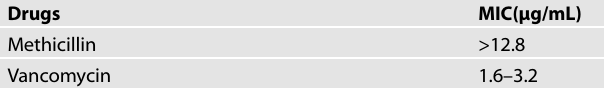
Fig. 6 Drug testing methods for mPEOs in the USA300 infection model. A Overview of the three methods protocol steps (created with BioRender.com). The viability of infected mPEOs after treatment with DMSO, 12.8 μ g/mL methicillin, 1.6 μ g/mL and 3.2 μ g/mL vancomycin was analyzed using a CellTiter-Lumi ™ ATP assay. B Method A ( n = 6, Ctrl group: 89119.28 ± 33928.97; Infection group: 20019.28 ± 18394.53; DMSO group: 4806.33 ± 1301.42; Met 12.8 μ g/mL group: 21418.17 ± 9640.48; VA 1.6 μ g/mL group: 8560.96 ± 8868.99; VA 3.2 μ g/mL group: 37237.76 ± 39975.97). C method B ( n = 6, Ctrl group: 137746.08 ± 39574.03; Infection group: 34833.32 ± 7176.01; DMSO group: 35910.03 ± 6193.07; Met 12.8 μ g/mL group: 45786.43 ± 7628.59; VA 1.6 μ g/mL group: 73176.32 ± 31063.43; VA 3.2 μ g/mL group: